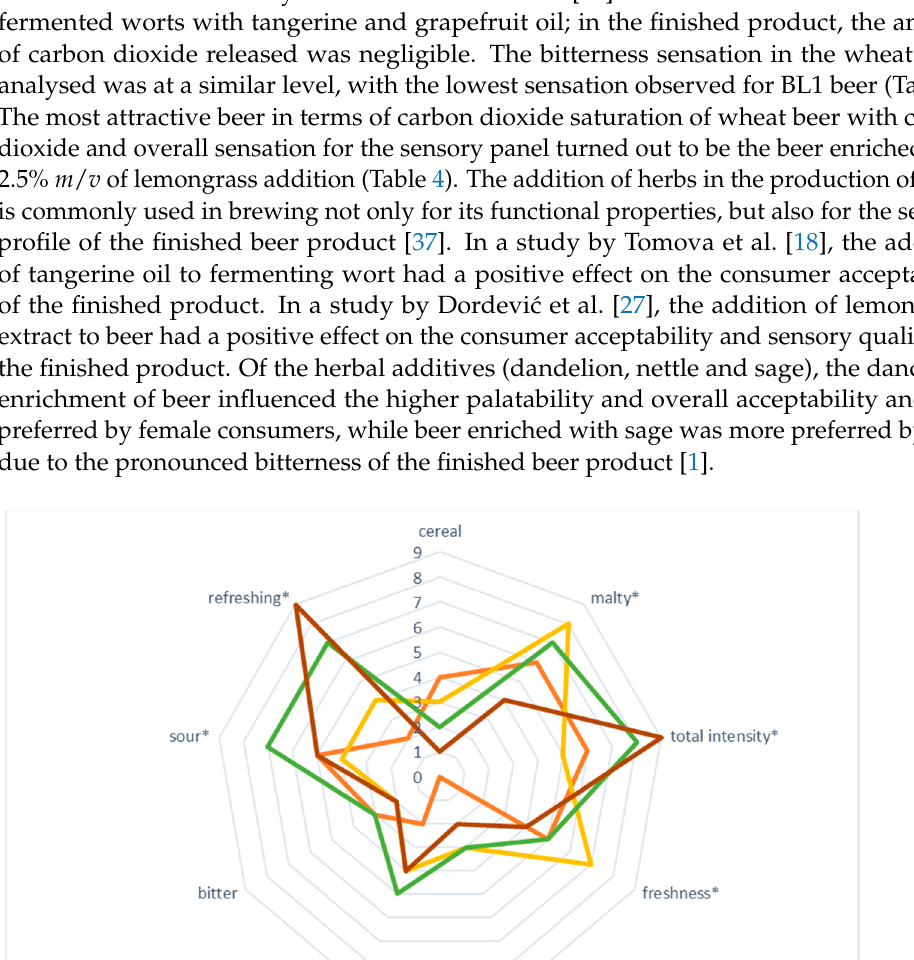
Table 4. Sensory analysis of wheat beers fortified with lemongrass extract.